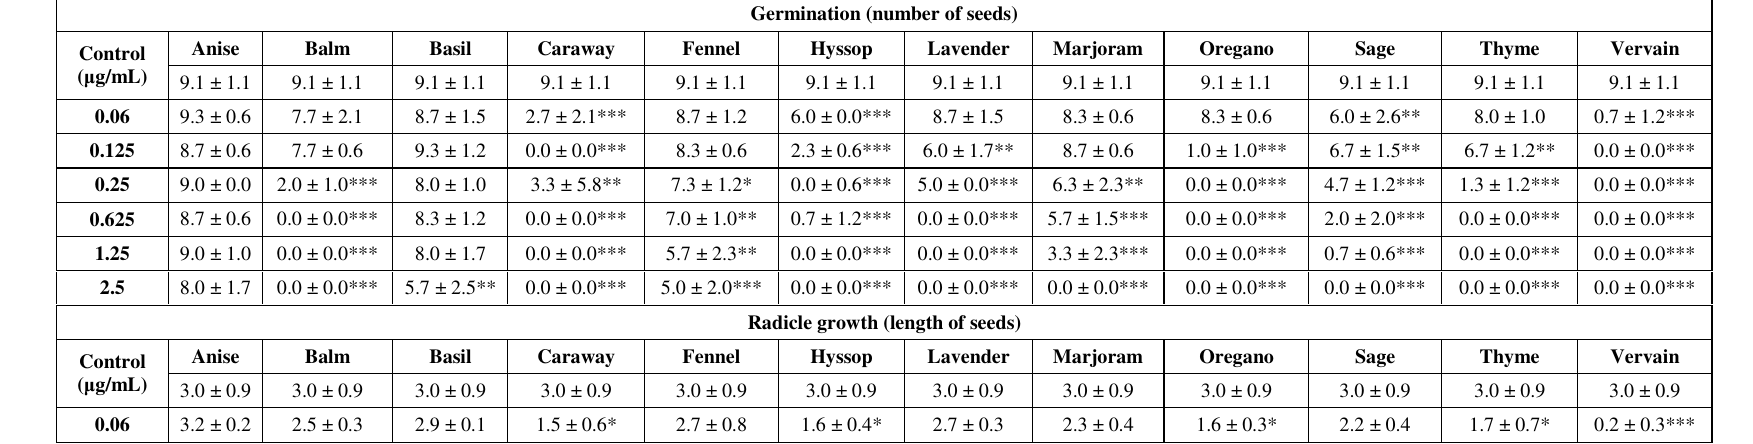
Table 4. Effects of different doses of essential oils on germination and radicle elongation of Raphanus sativus . The data are expressed as mean of three replicates ±